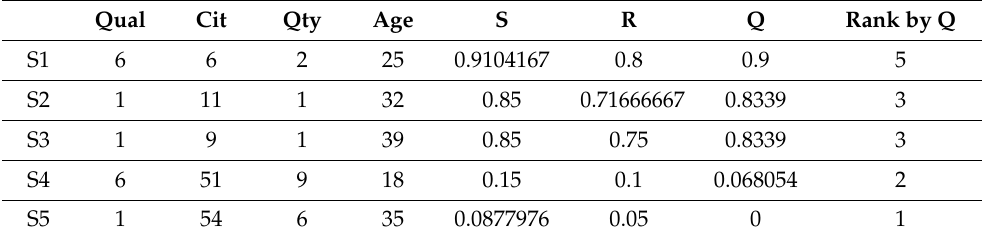
Table 2. Ranking of 5 journals with different weight on criteria. Qual means Quality, Cit is Citation, Qty stands for Paper Quantity, and Age means the Age of